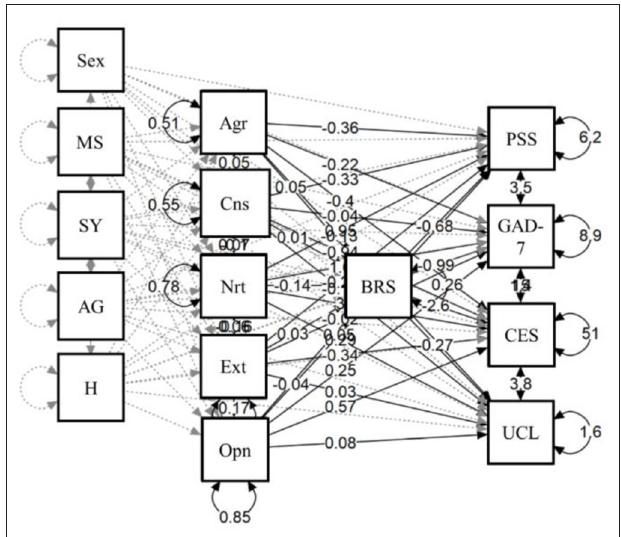
FIGURE 1 | Resilience as a mediator in the personality-mental health relationship. MS, marital status; SY, school years; AG, age groups; H, housing; Agr, agreeableness; Cns, conscientiousness; Nrt, neuroticism; Ext, extraversion; Opn, openness; BRS, brief resilience scale; GAD-7, generalized anxiety disorder-7; CES-D, center for epidemiologic studies-depression; UCLA, UCLA three-item loneliness scale; PSS, perceived stress scale.